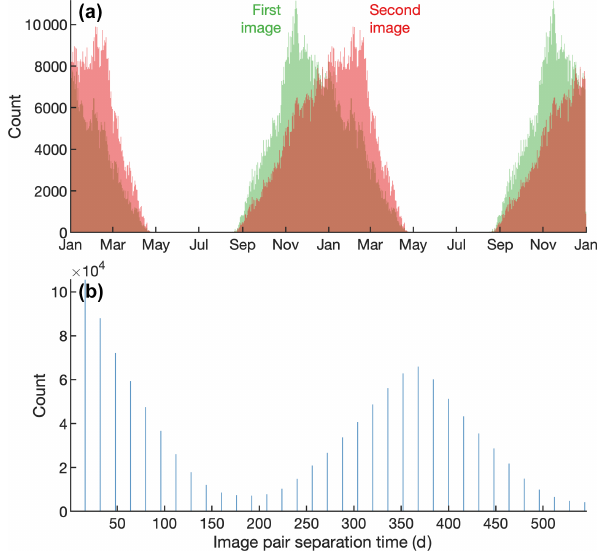
Figure 2. Antarctic image pair acquisition times. Over 1.8 mil- lion Landsat image pairs provide Antarctic ice velocities in the ITS_LIVE dataset. (a) The seasonal cycle of Landsat image col- lection shows the effects of the solar cycle on Antarctic sampling. The cycle is repeated for visual continuity over the summer. (b) Dis- placement fields in the ITS_LIVE dataset are processed for all im- age pairs separated by 16 to 544d, with half of all image pairs rep- resenting 80d of displacement or less, but a distinct secondary peak corresponds to a (cid:49)t value of 1